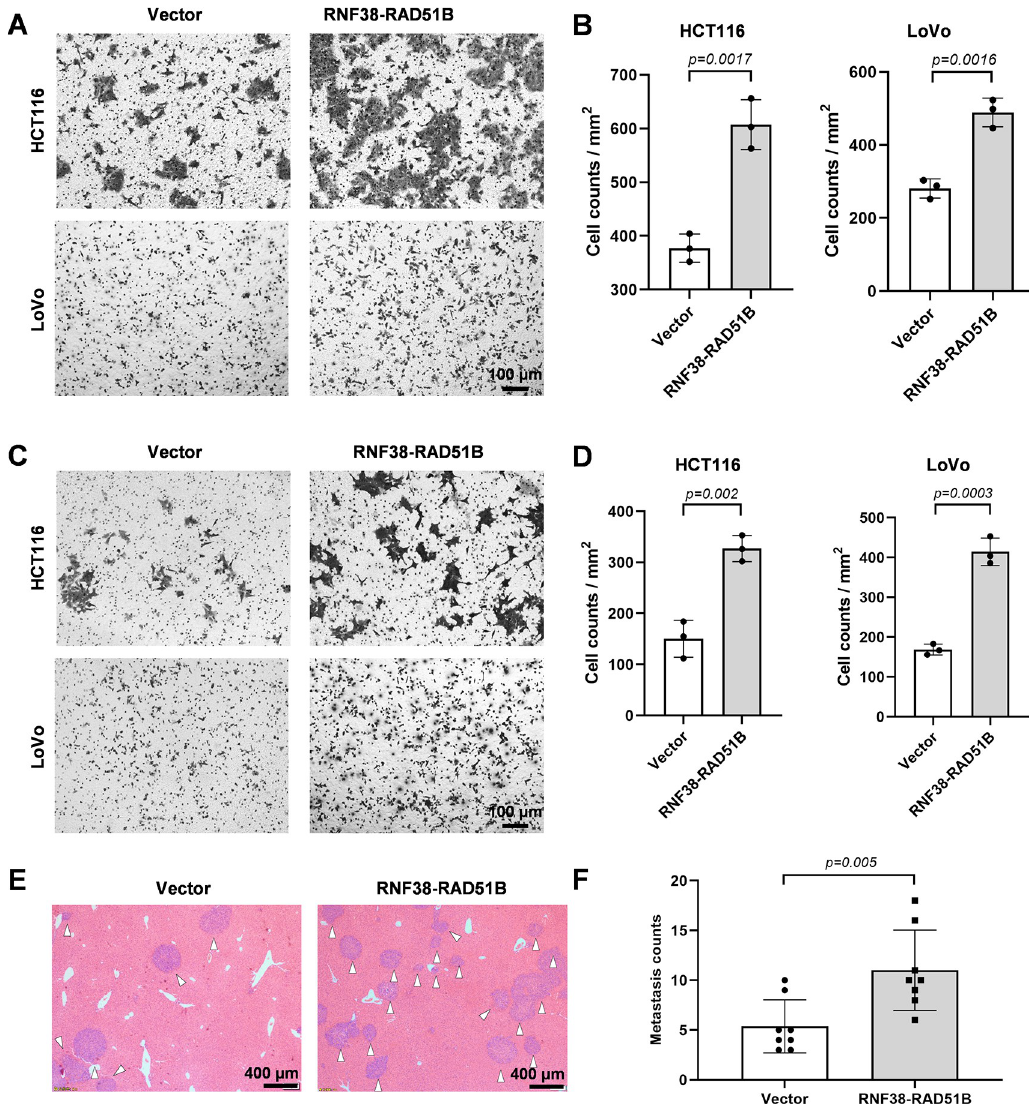
Fig 5. RNF38-RAD51B promotes cell migration, invasion and CRC metastasis. (A, B) Representative images (A) and statistical results (B) of transwell migration assay of RNF38-RAD51B overexpressing CRC cells (three repetitions per group). (C, D) Representative images (C) and statistical results (D) of transwell invasion assay of RNF38-RAD51B overexpressing CRC cells (three repetitions per group). (E, F) Representative H&E-staining images (E) and counts (F) of metastatic tumors in the liver of the xenograft mice intravenously injected with RNF38-RAD51B overexpressing HCT116 cells (eight mice per group). p < 0.05 are statistically significant (students’ t